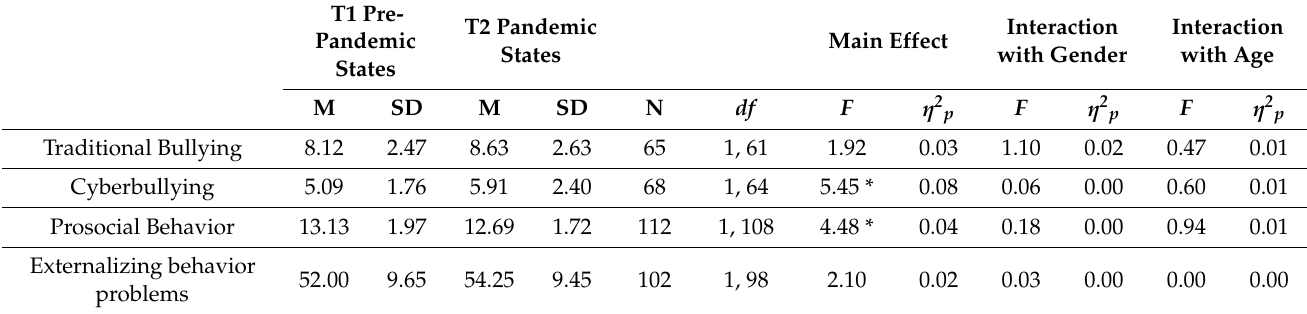
Table 5. ANOVA with repeated measurements in pre-pandemic and pandemic states. T1 Pre-